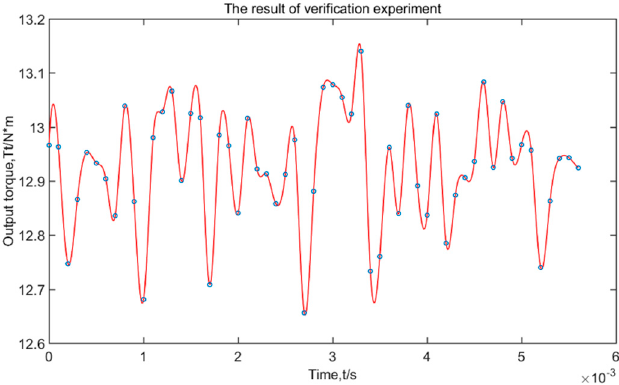
Figure 11. Time-varying torque of the simulation verification experiment. Table 4. Comparison of the result of optimization and the verification experiment.